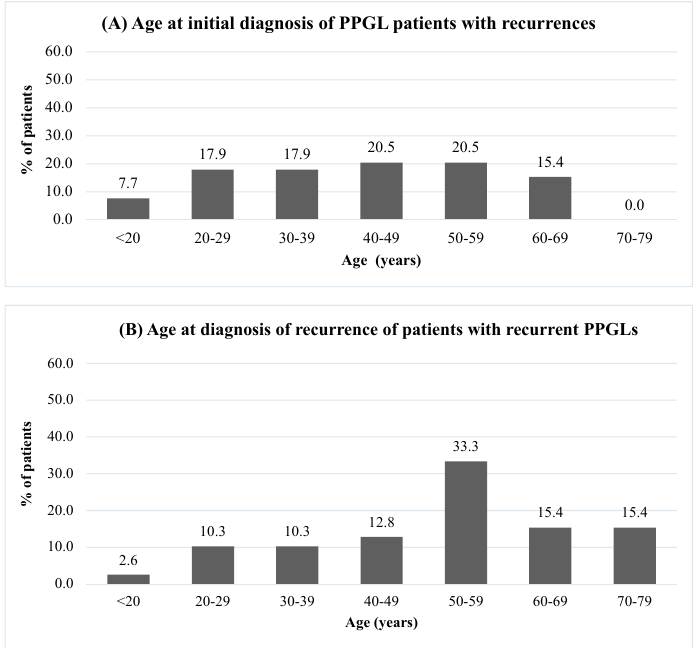
Figure 2. Age of patients with PPGLs at initial diagnosis and recurrence. Notes: PPGLs: pheochro- mocytomas and paragangliomas. ( A ) Age at initial diagnosis of PPGL patients with recurrences. ( B ) Age at diagnosis of recurrence of patients with recurrent PPGLs.